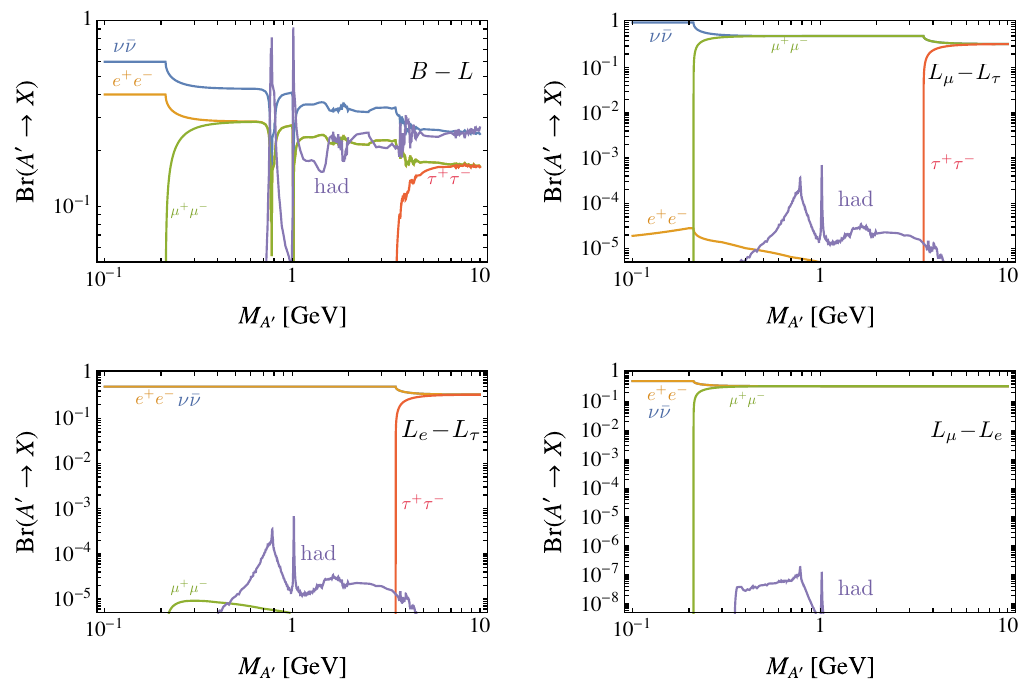
Figure 3 . Branching ratios for the gauge bosons of a U(1) right), U(1) L (lower left) and U(1) L e (cid:0) L (cid:28) the branching ratio into neutrinos is indistinguishable from Br( A 0